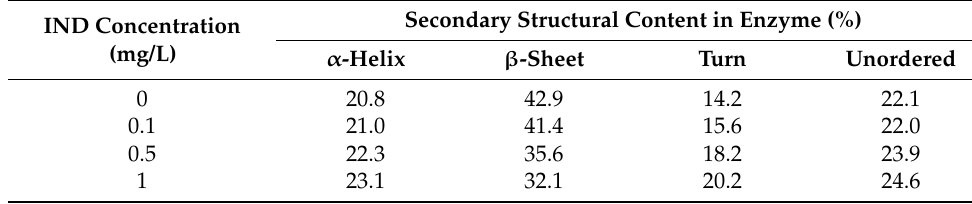
Table 3. Secondary structure content of SOD before and after exposure to